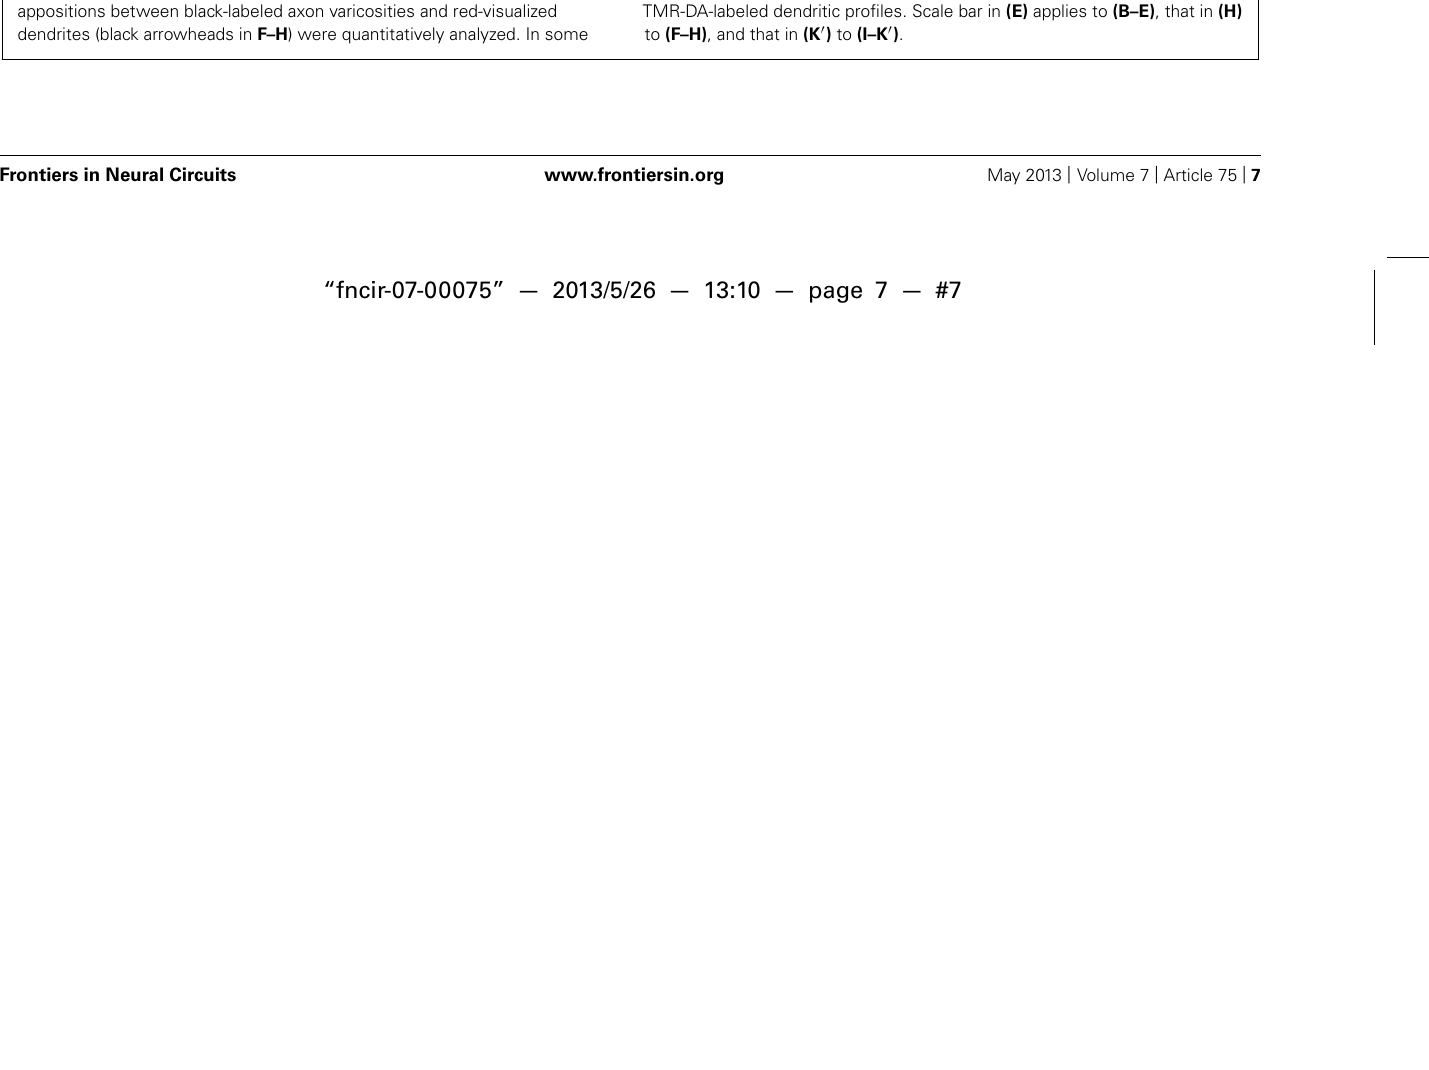
samples, the appositions were confirmed to make synaptic contacts in electron-microscopic images (I–K (cid:4) ) , where black arrowheads and arrows indicated the postsynaptic densities and immunoreaction products for TMR-DA, respectively. Figure (K) is the image next to (K (cid:4) ) , in which a white arrow points to the spine neck connecting the unlabeled spine to the TMR-DA-labeled dendrite. (B–K (cid:4) ) Modified with permission from Figures 1 and 8 ofCho etal. (2004b). AT, intracellularly labeled axon terminals; Den, TMR-DA-labeled dendritic profiles. Scale bar in (E) applies to (B–E) , that in (H) to (F–H) , and that in (K (cid:4) ) to (I–K (cid:4) )